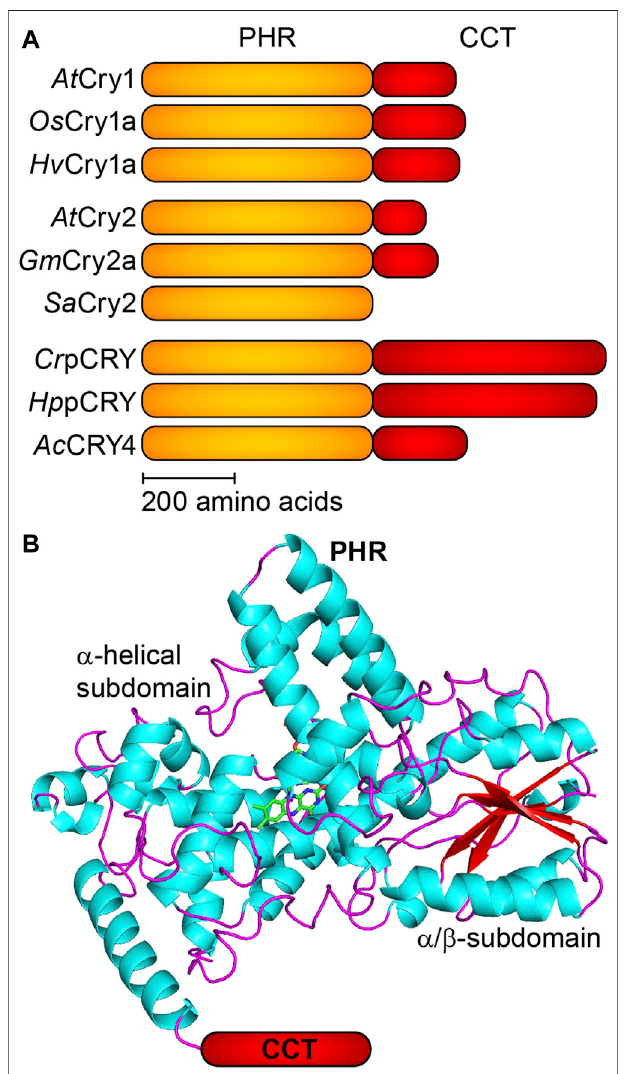
FIGURE 1 | Schematic domain topology and structure of plant cryptochromes (pCRY). (A) Plant cryptochromes share a conserved PHR domain and a CCT of varying length. Cr pCRY exhibits the longest CCT with ∼ 500 amino acids. The selected pCRY originate from Arabidopsis thaliana ( At CRY1 and At CRY2), rice Oryza sativa ( Os CRY1a), barley Hordeum vulgare ( Hv CRY1a), soybean Glycinemax ( Gm CRY2a),whitemustard Sinapis alba ( SaCRY2 ), green alga Chlamydomonas reinhardtii ( Cr pCRY), green alga Haematococcus pluvialis ( Hp pCRY) and fern Adiantum capillus-veneris ( Ac CRY4). (B) The PHR domain of pCRY comprises an α -helical subdomain binding FAD and ATP as well as an α / β -subdomain with a parallel β -sheet (PDB:1U3D). The CCT isconnected tothe C-terminal region ofthePHR but is not resolved in the crystal structure.